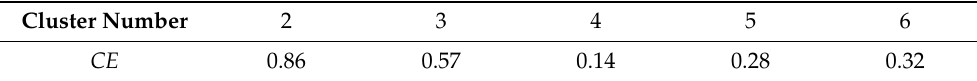
Table 5. E rse and E mres of voltage in